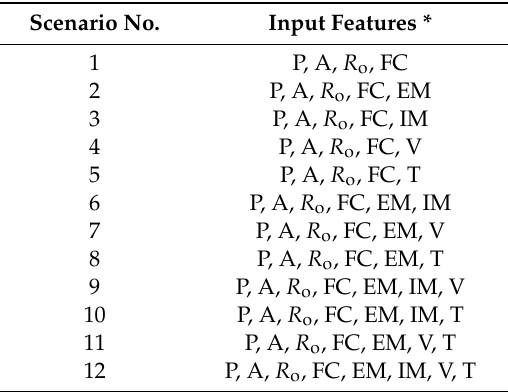
Table 4. Input feature scenarios for analyzing the estimation